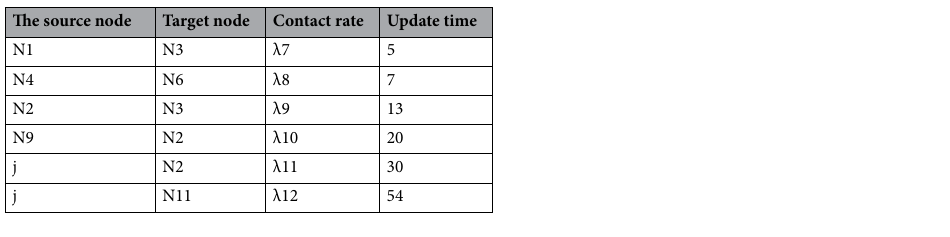
Table 3. Contact rate estimation table of node